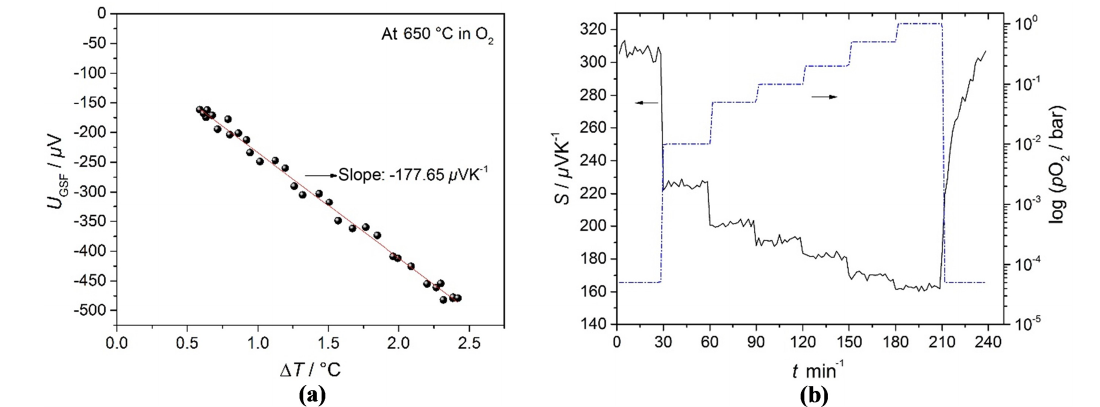
Figure 7. (a) Example of a regression analysis in an oxygen atmosphere and (b) the p O 2 dependence of the Seebeck coefficient of BFAT30 AD thick film at 650 ◦ C.